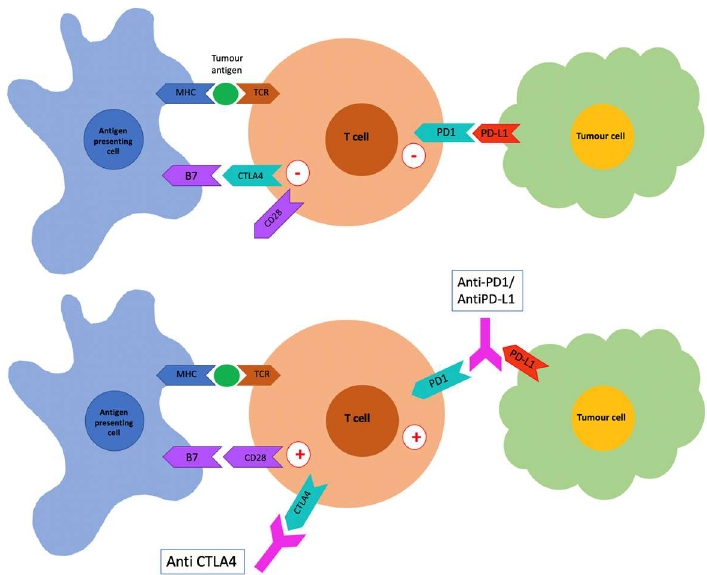
Figure 2. T cell activation requires presentation of tumor antigen to the T cell receptor (TCR) by major histocompatability complex (MHC) on the antigen-presenting cell (APC) and also co-stimulation via B7 on the APC binding to CD28 on the T cell. Cytotoxic T lymphocyte associated protein 4 (CTLA4) is an inhibitory molecule that binds B7 with a higher infinity than CD28 and downregulates the T cell. In addition, PD1 on the T cell binds PD-L1 expressed by tumor cells, which also acts to downregulate the T cell. Immune checkpoint inhibitors, including anti-CTLA4, anti-PD1, and anti-PD-L1 monoclonal antibodies, block the interaction of B7 with CTLA4 and PD1 with PD-L1, eliminating the inhibitory signal and upregulating the T cell.